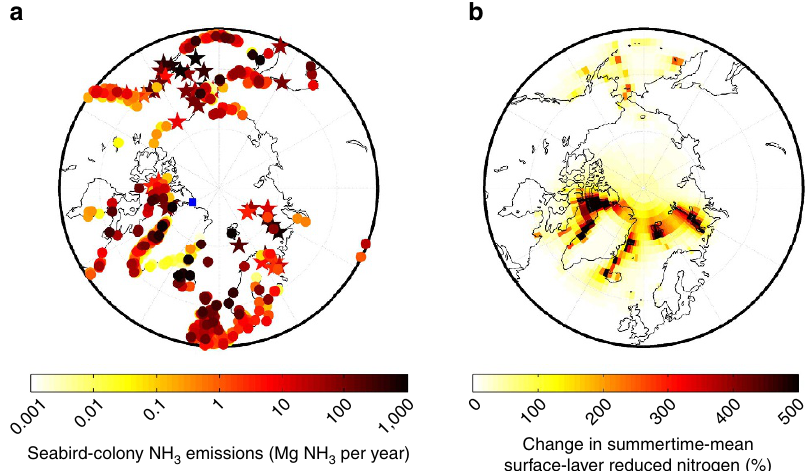
Figure 2 | Arctic seabird-colony NH 3(g) emissions and impacts on atmospheric surface-layer NH 3(g) and NH 4 þ (p) mixing ratios. ( a ) Locations and annual emissions of NH 3(g) from Arctic seabird colonies. Circles indicate colonies in the Riddick et al. 18,19 inventory and stars are additional colonies from the Circumpolar Seabird Data Portal 30 . The blue square shows the location of Alert, Nunavut, Canada. ( b ) Percent change in summertime mean atmospheric surface-layer total reduced nitrogen (gas-phase ammonia (NH 3(g) ) and particulate ammonium (NH 4 þ (p) )) attributed to the seabird-colony NH 3 emissions for the GEOS-Chem-TOMAS